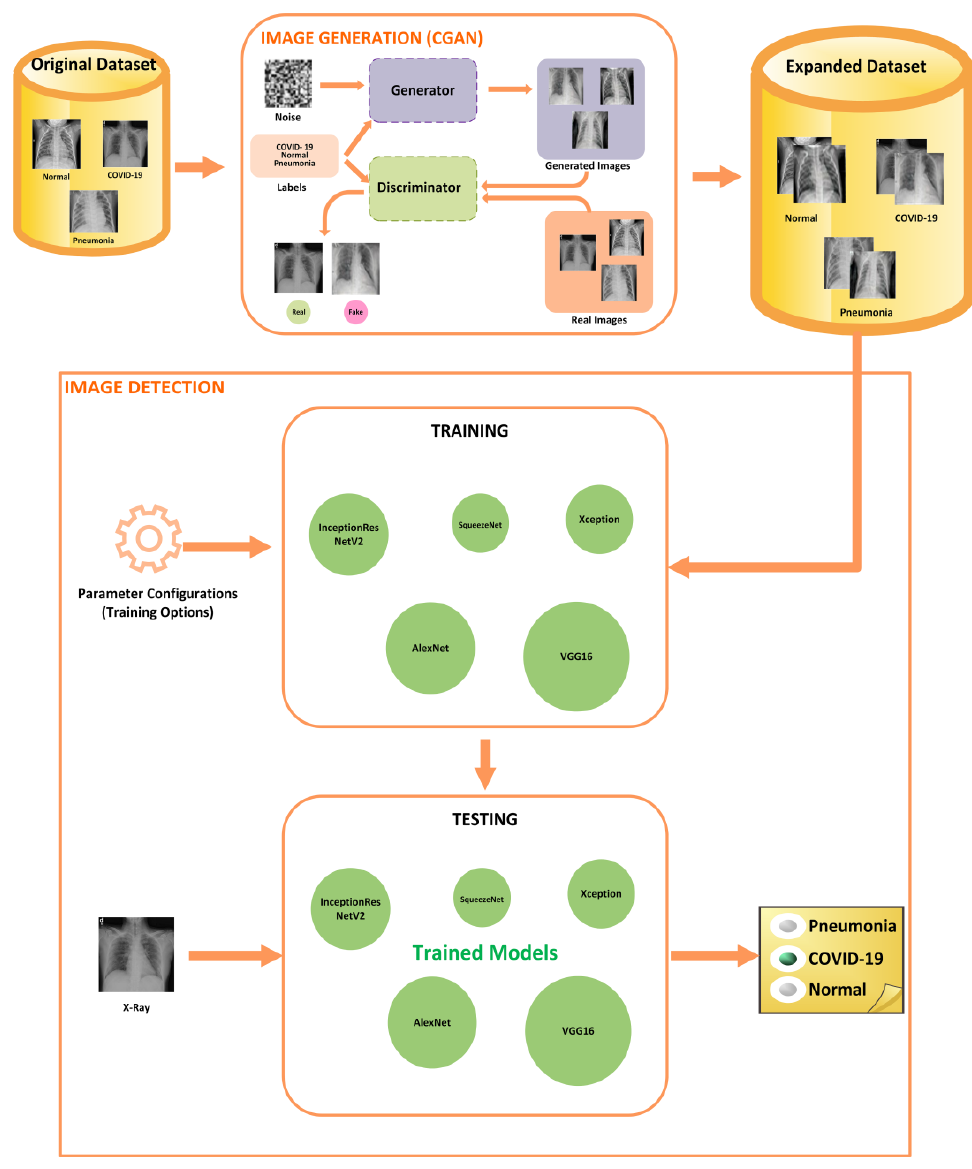
Figure 1. A block diagram of COVID-CGAN.